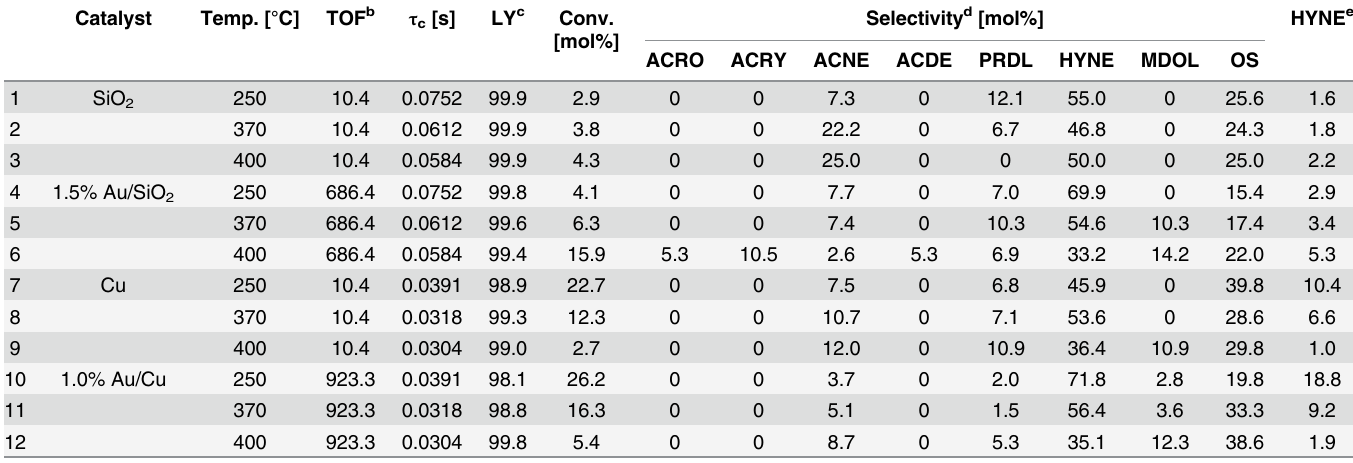
Table 5. Catalytic performance of Cu- and SiO 2 -supported Au NPs in diluted glycerol solutions at 250 – 400°C a . Catalyst Temp.